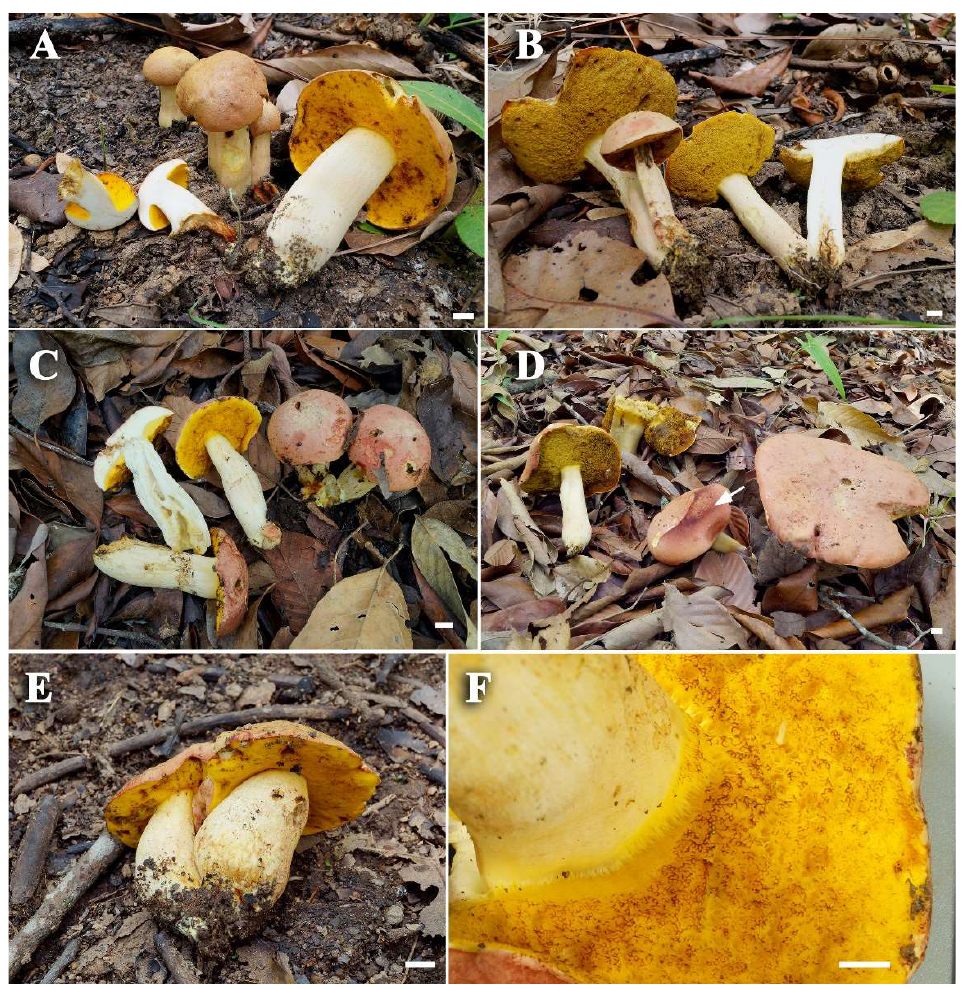
Figure 3 . Fresh basidiomata of Rubinosporus auriporus: ( A , B ) SV0090 (Holotype); ( C , D ) SV0394, spores deposit on the cap showing dark ruby color (white arrow); ( E ) SV0396; ( F ) the golden yellow pores, irregularly reddish brown at places in (SV0394)—Bars ( A – E ) = 1, ( F ) = 5 mm.